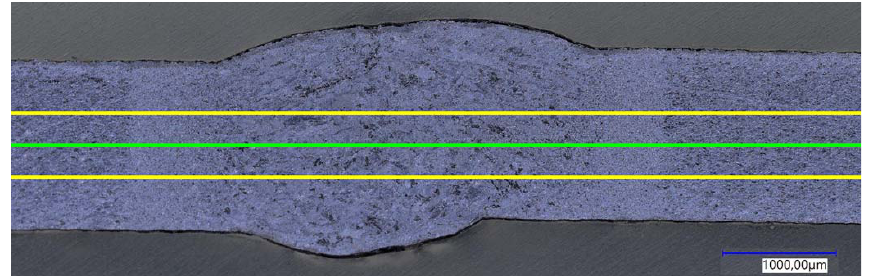
Figure 4. Representative diagram of the microhardness measurement locations: in the sample axis - green line, at a distance of 0.25 mm from the sample axis - yellow lines.